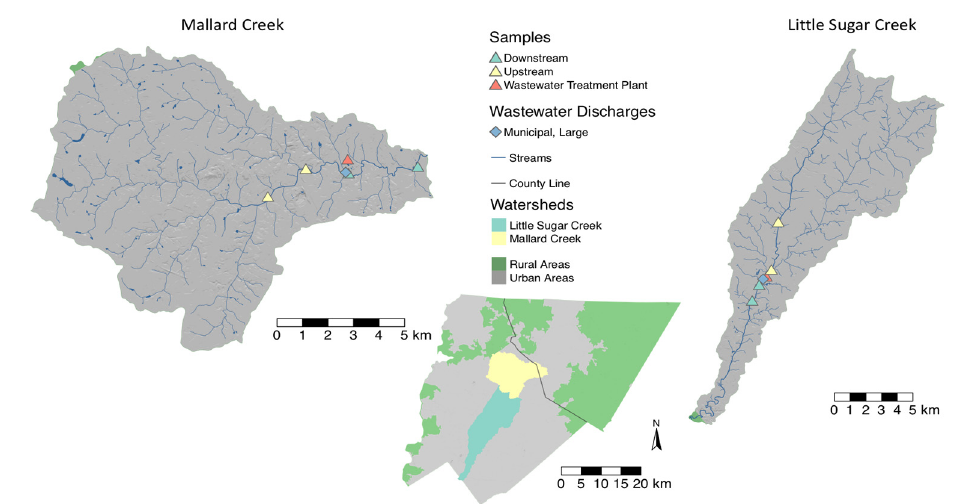
Figure 1. Locations of wastewater treatment plants, effluent discharge, and sampling locations. Both watersheds are located in Mecklenburg County, NC with Mallard Creek extending slightly into western Cabarrus County, NC.